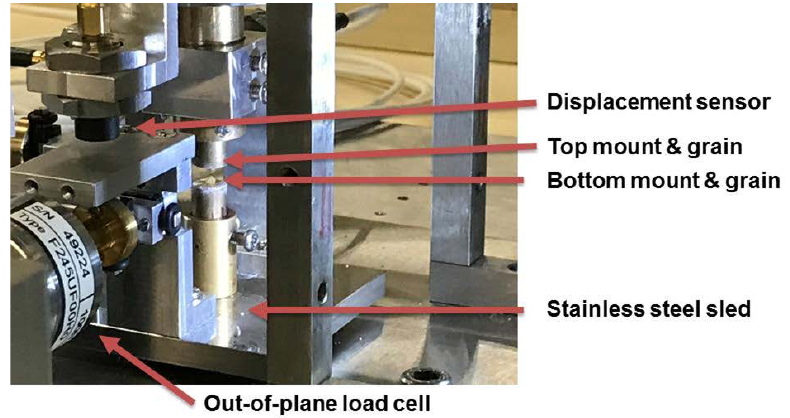
Figure 5. Close-up view of the micromechanical sliding apparatus of City University of Hong Kong during the set of a test on LBS grains.